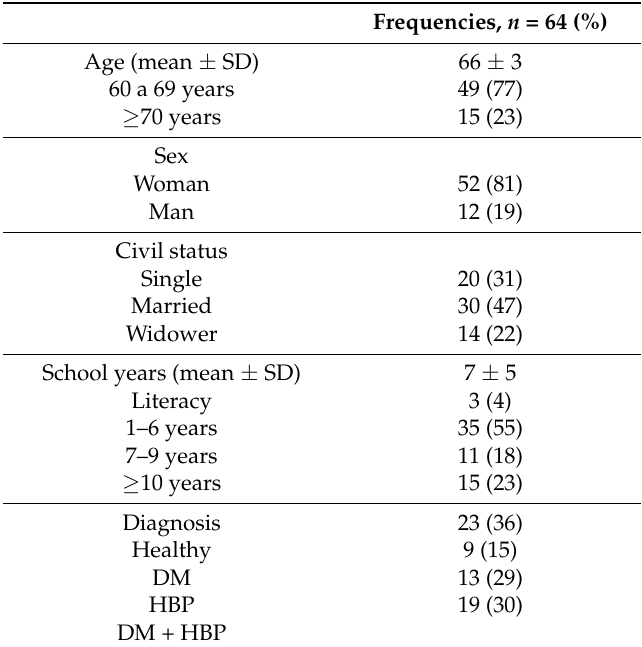
Table 3. Sociodemographic characteristics and health status of the study population.